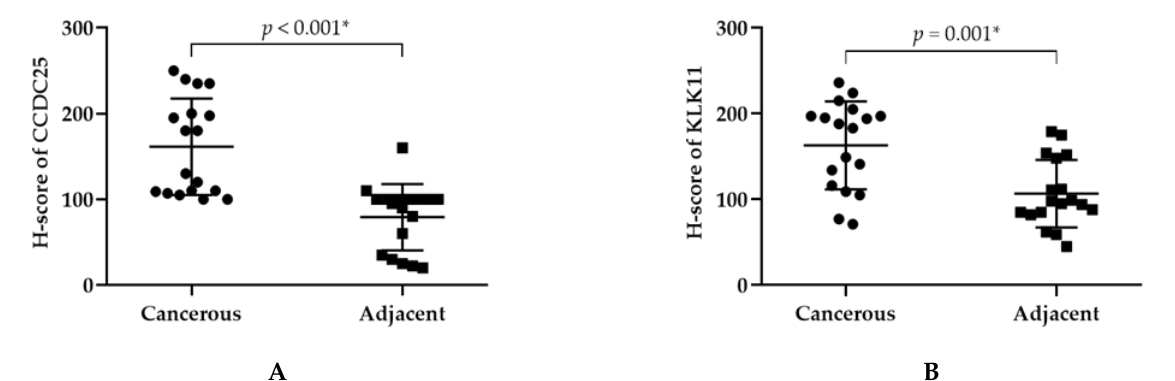
Figure 2. H-scores of CCDC25 and KLK11 in CCA tissues by using immunohistochemistry. ( A ) H-score of CCDC25. ( B ) H-score of KLK11. Mann–Whitney U test was used to compare H-scores between cancerous and adjacent tissues of CCDC25 and KLK11. * Statistical significance ( p < 0.05).